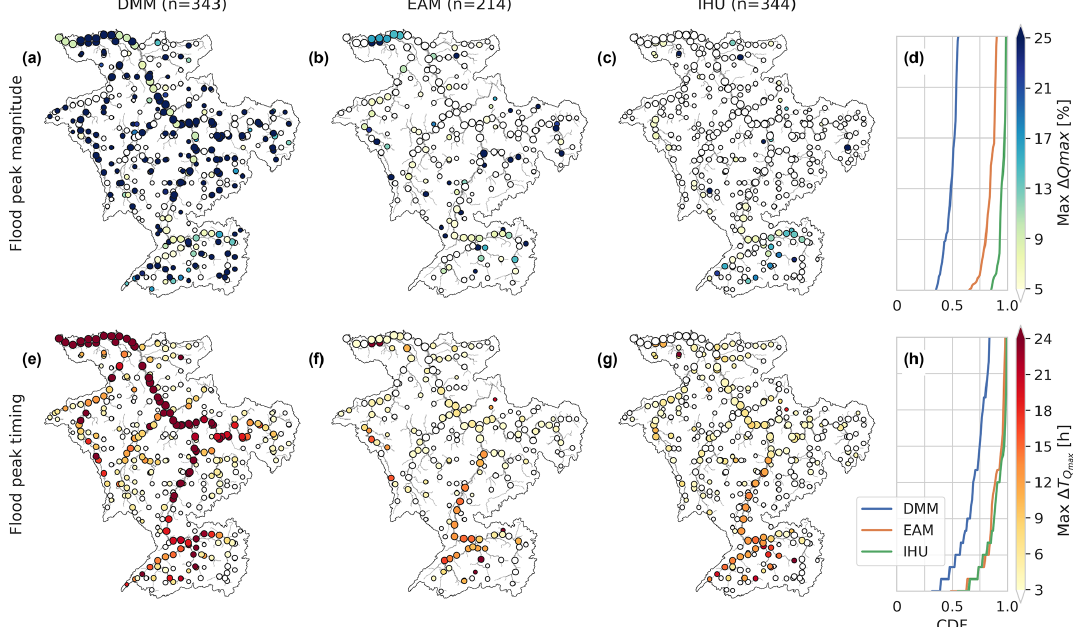
Figure 8. Maximum absolute difference in simulated flood peak magnitude ( (cid:49)Q max – top row) and flood peak timing ( (cid:49)T Q row) between upscaled (30arcsec, 5 and 15arcmin) and the baseline (3arcsec) resolutions in the Rhine basin based on the DMM (first column), the EAM (second column) and IHU (third column) upscaling methods. The right-most panels show the cumulative distribution function (CDF) curve for each method, with N denoting the number of comparable outlet pixel locations across all resolutions which are selected based on a maximum 1% upstream area difference. The marker size is scaled with the upstream area, and markers are plotted in order of increasing upstream